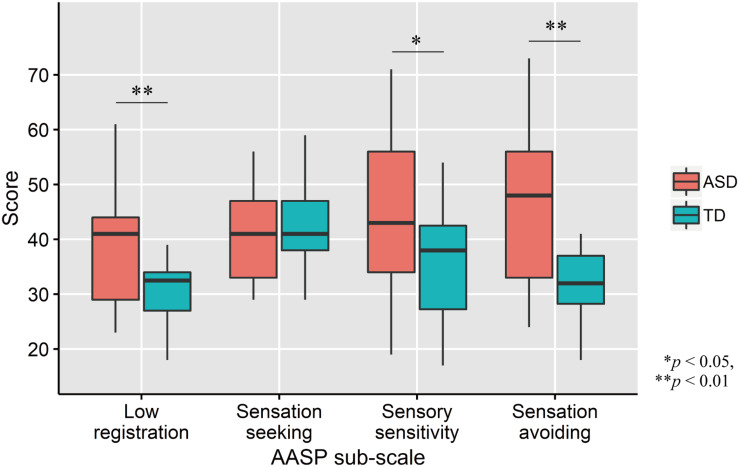
Distribution of AASP scores in each group. The upper and lower boundaries of the standard boxplots represent the 25th and 75th percentiles. The horizontal line across the box marks the median of the distribution. The ends of vertical lines below and above the box represent the minimum and maximum values, respectively. Asterisks represent significant difference by two-tailed t test.